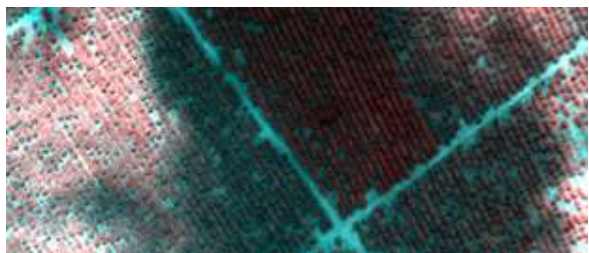
Figure 5. Color composition of LRcube: R840.3 nm, G 840.3 nm and B 506.1 nm